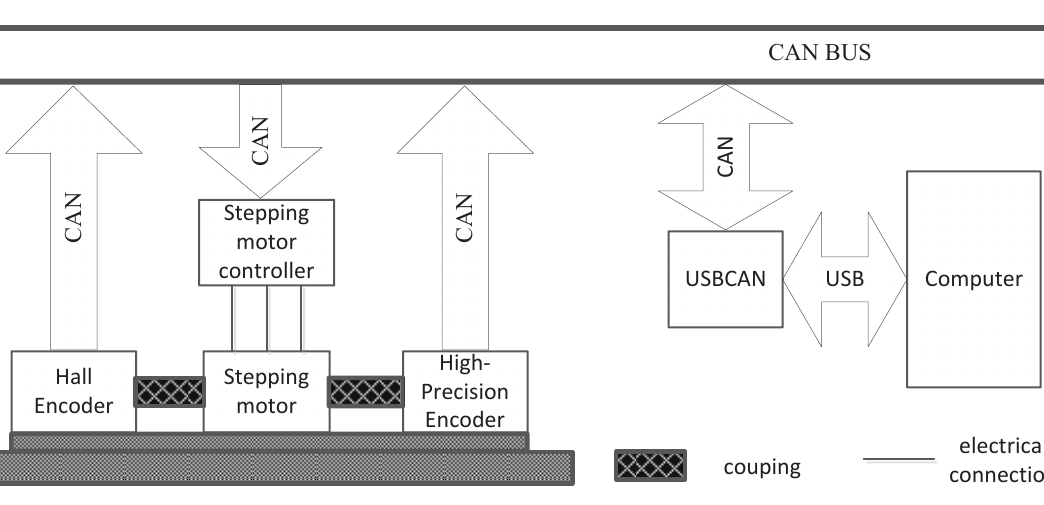
Figure 10. The structure of the diagnostic